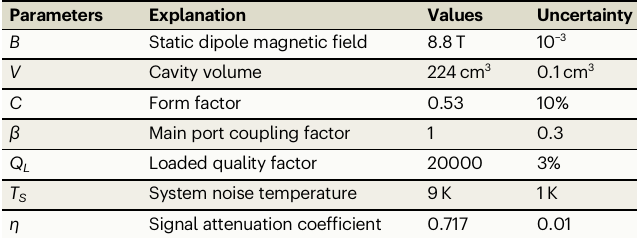
Table 2 | CAST-CAPP parameters and related uncertainties used for the analysis. Note that the loaded quality factor is given for the frequency of 5.3